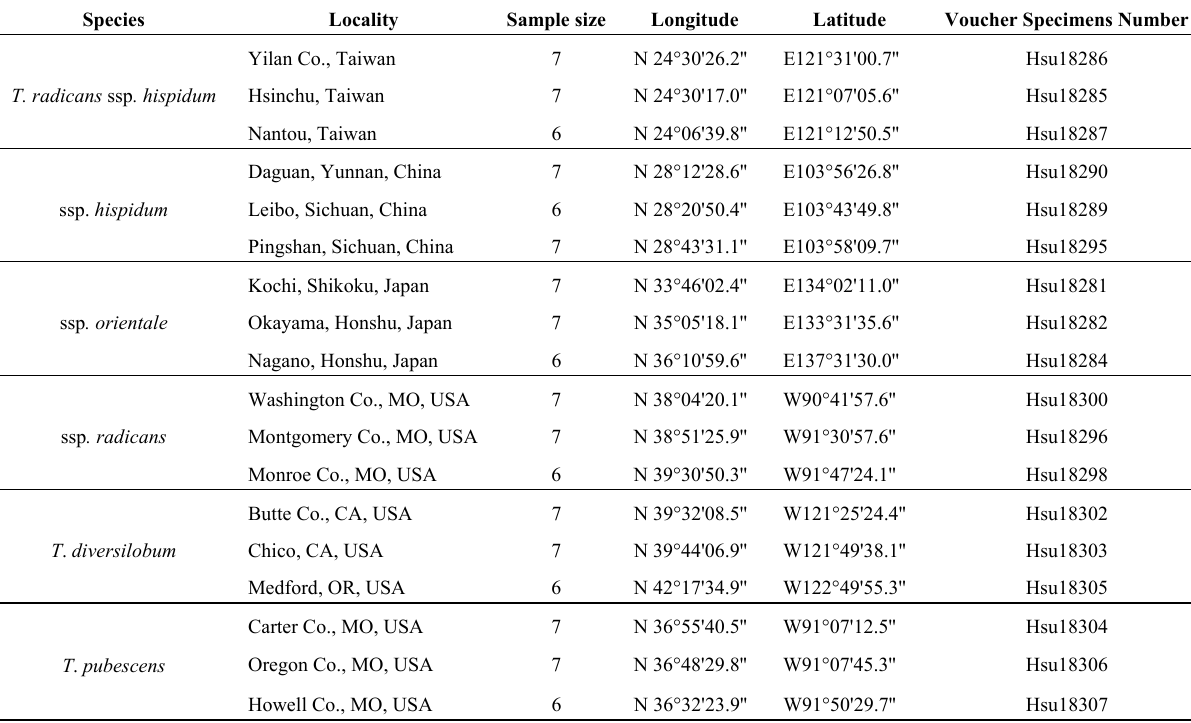
Table 2. Sample location for each species, subspecies, and populations of Toxicodenderon . Sample size, location, coordinate, and voucher specimens are